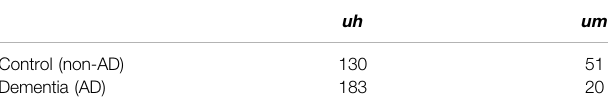
TABLE 1 | Subjects with AD say uh more often, and um less often.